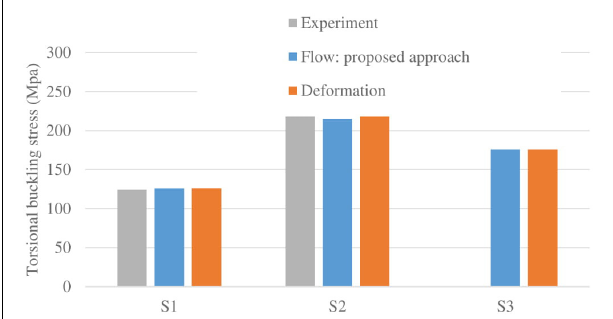
FIGURE 7 | Comparison between the torsional buckling stresses obtained by the plasticity theories and experimental results (with imperfection size 10% of the flange thickness) (Guarracino and Simonelli,